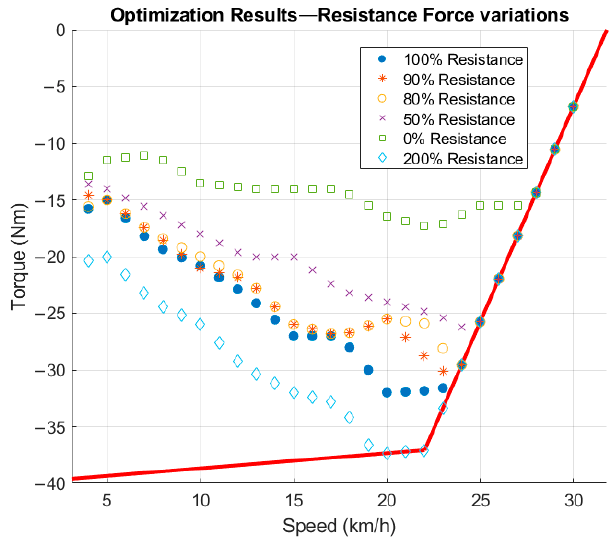
Figure 9. Optimization results of the resistance force parameter change.